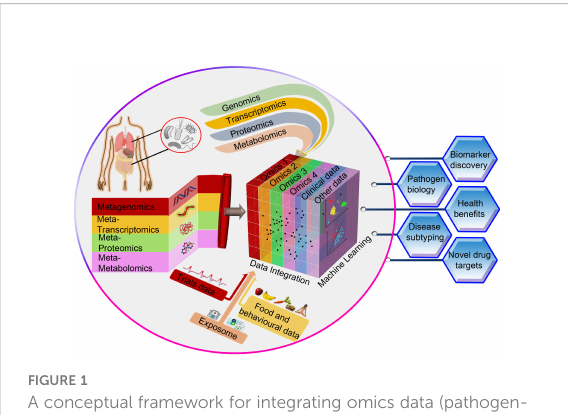
FIGURE 1 A conceptual framework for integrating omics data (pathogen- speci fi c data and community-level data) with non-omics datasets such as clinical metadata through machine learning techniques. This approach is very likely to advance our understanding of infectious diseases and accelerate the identi fi cation of novel diagnostic or therapeutic targets that can improve human